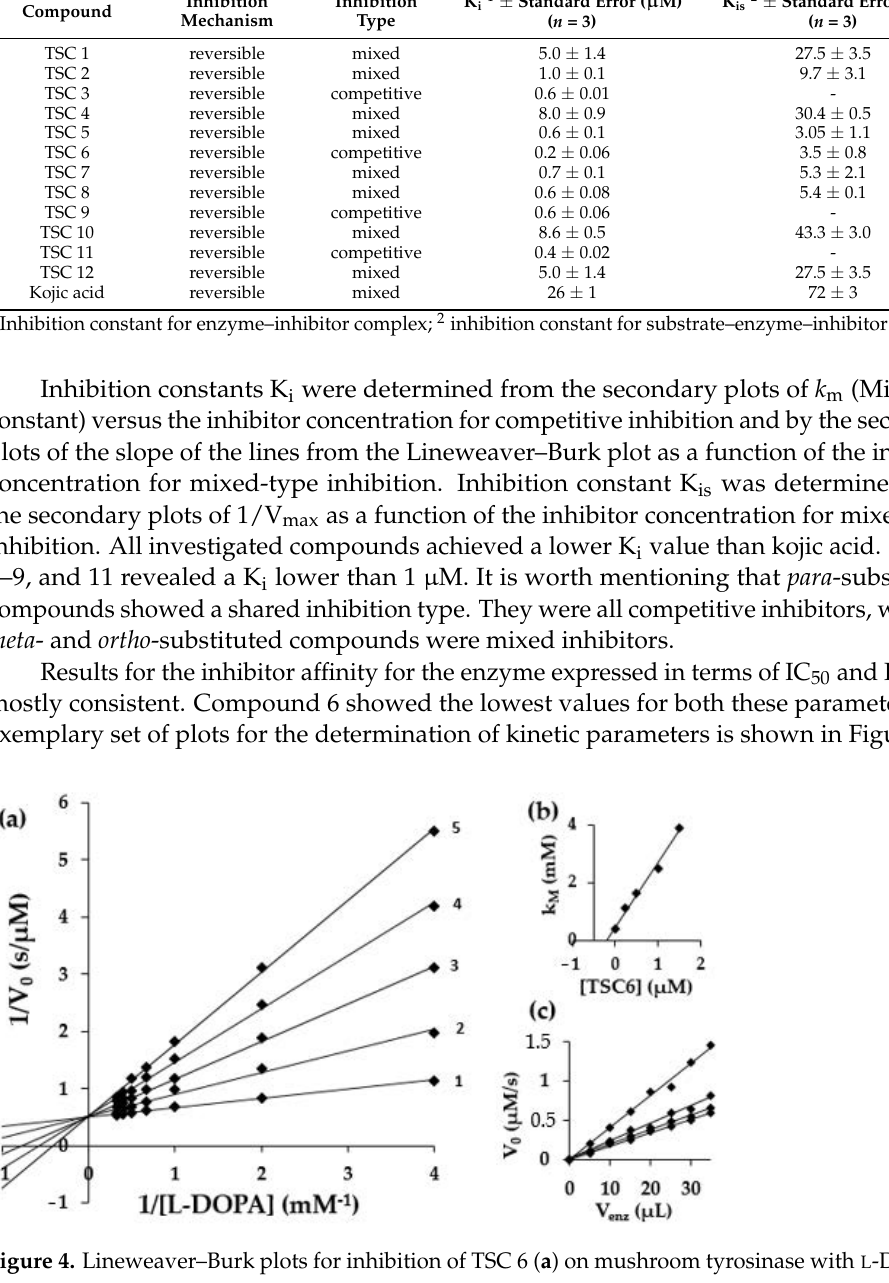
Figure 4. Lineweaver–Burk plots for inhibition of TSC 6 ( a ) on mushroom tyrosinase with L -DOPA as substrate. The concentrations of TSC 6 for curves 1–5 were 0.0, 0.1, 0.2, 0.3, and 0.4 µM, respectively. ( b ) Secondary plot of k m versus inhibitor concentrations for determination of K i for competitive inhibition. ( c ) Plot to determine the inhibitory mechanism.